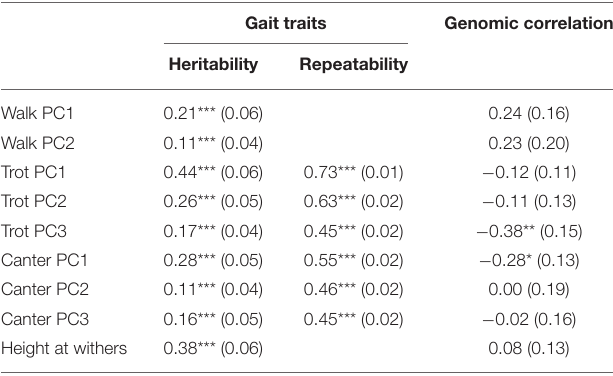
TABLE 3 | Heritability, repeatability of gait traits and height, and genomic correlation with functional longevity. Gait traits Genomic